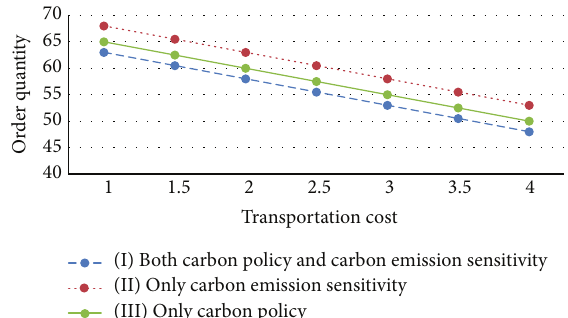
Figure 2 indicates that retailer optimal retail price is proportional to transportation costs. When the transporta- tion costs remain unchanged, consumers of carbon emission sensitivity own a lower product retail price compared with consumers of noncarbon emission sensitivity. When the government implements the carbon trade policy, product retail price is higher than that without carbon trade